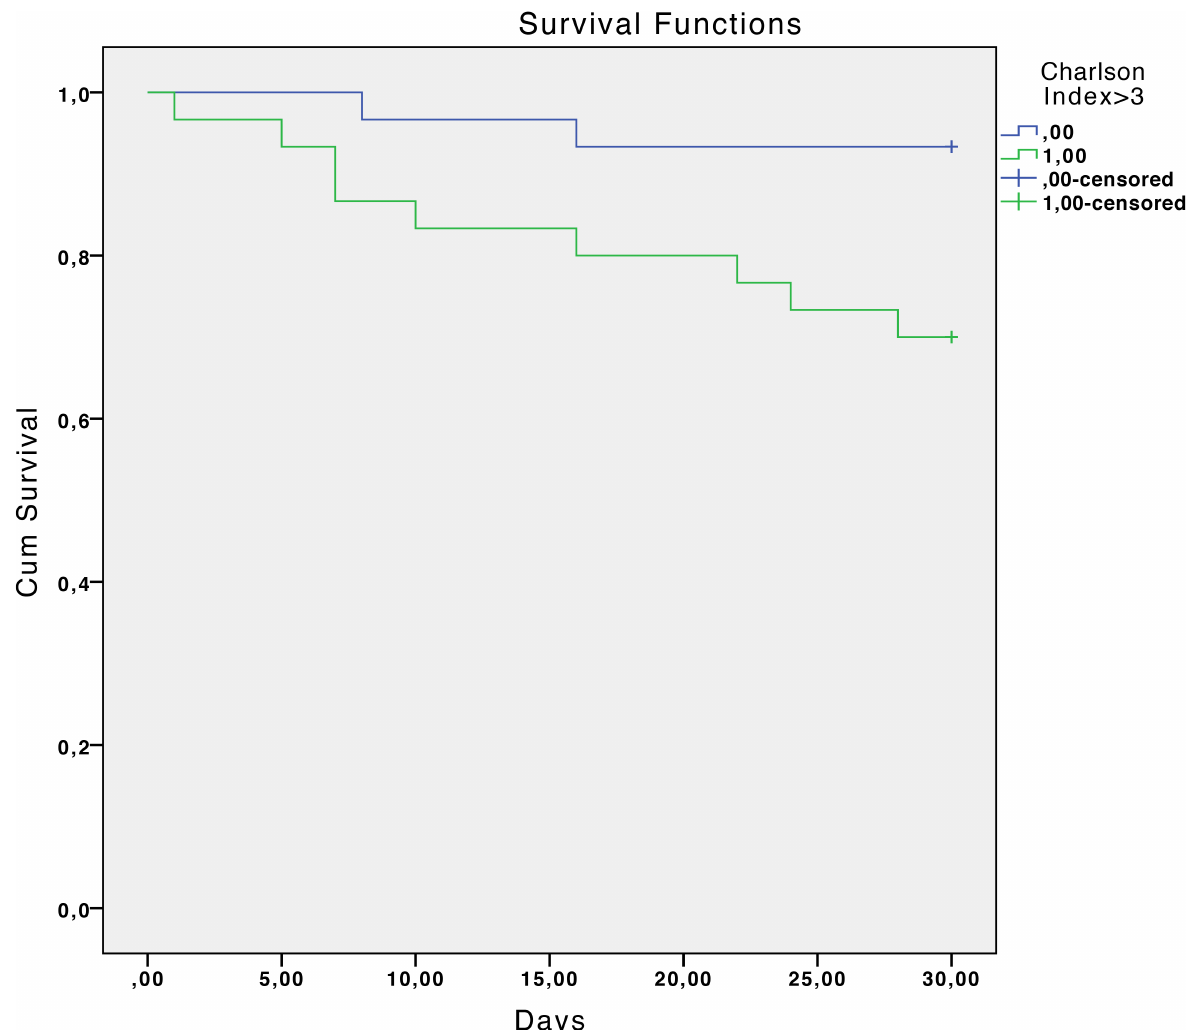
Fig 5. Kaplan-Meier 30-day survival curve according to Charlson index > 3. P = 0.02